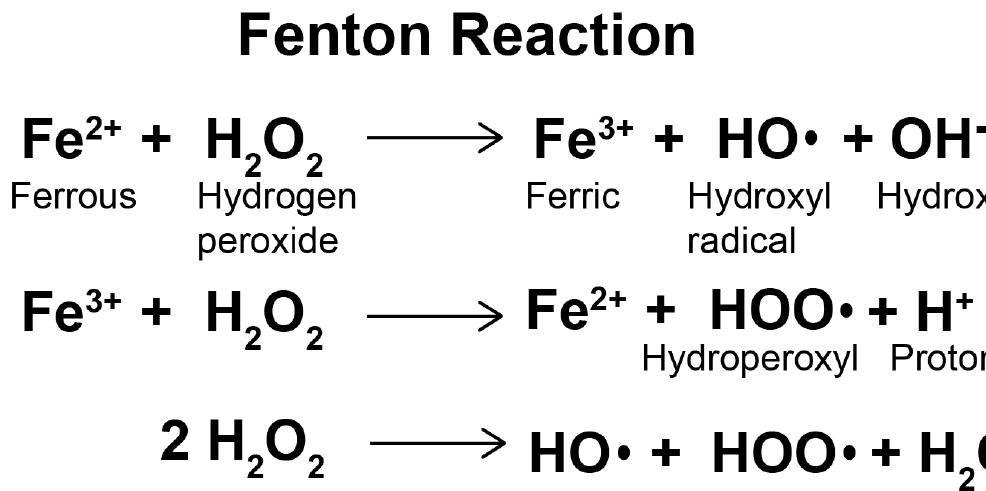
Figure 2. The Fenton reaction.